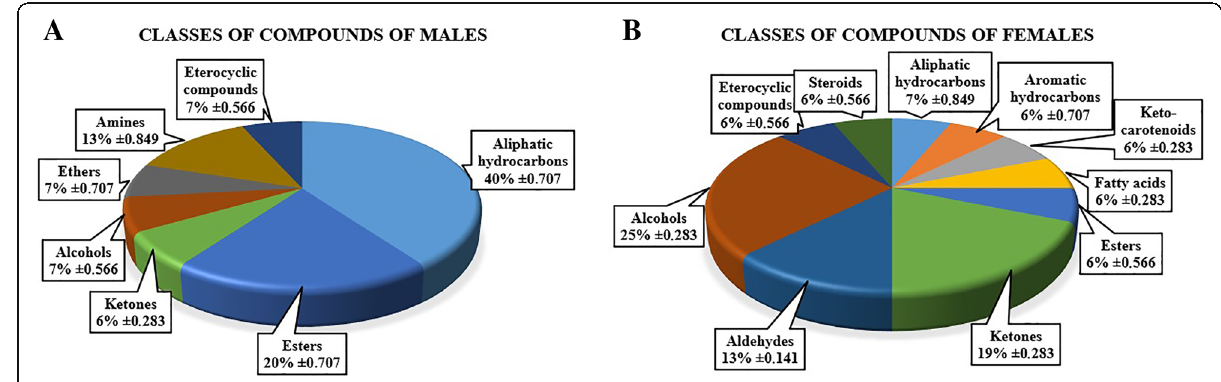
Fig. 2 Classes of compounds detected from male ( a ) and female ( b ) subjects are presented as percentage average (±